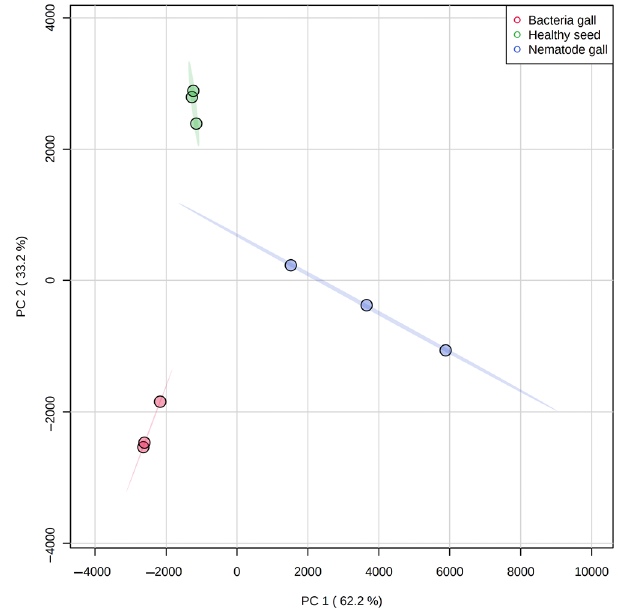
Figure 3. Principal component analysis (PCA) score plot for separation of metabolites in nematode gall ( Anguina funesta ), bacterial gall ( Rathayibacter toxicus ) and healthy seed of ryegrass ( Lolium rigidum ). The variances (PC1 and PC2) are shown in brackets. The three symbols for each treatment represent three biological replicates.